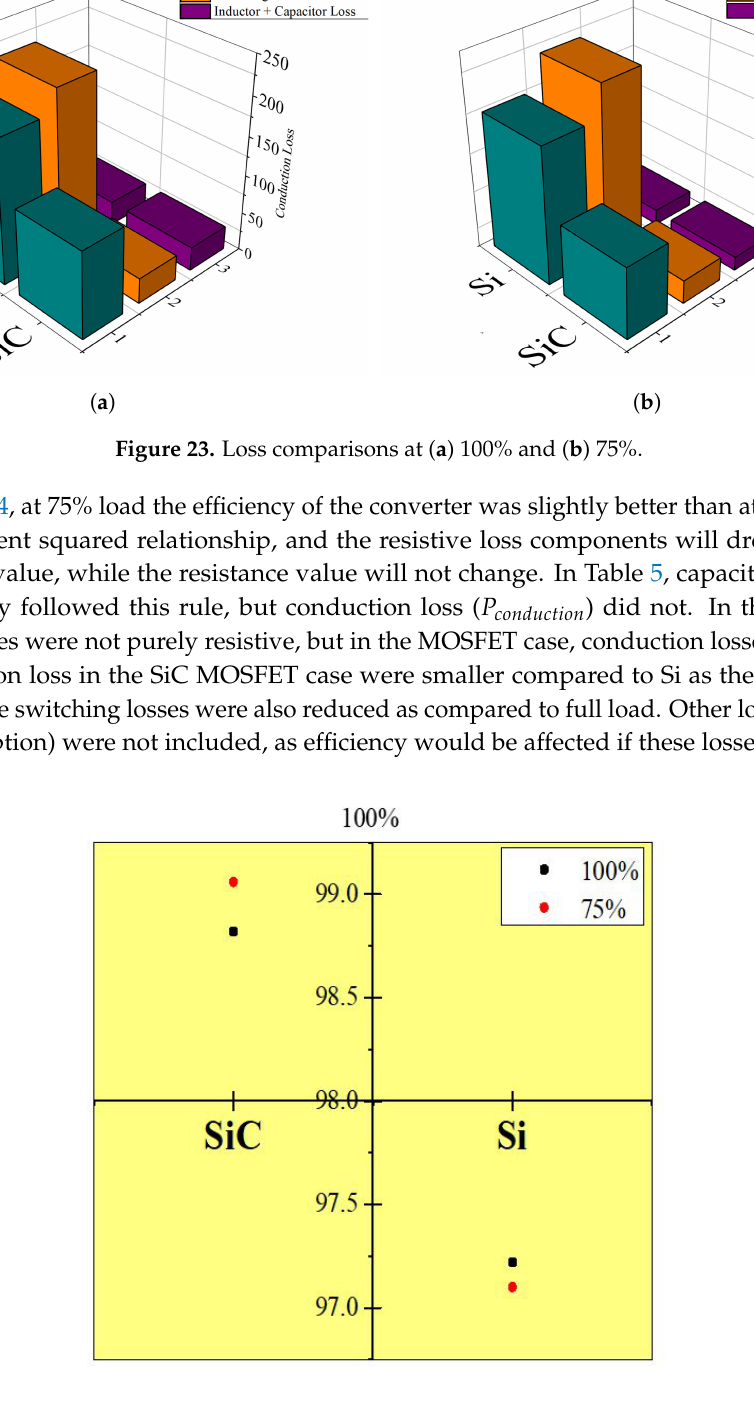
Figure 24. Efficiency comparison at 100% and 75%